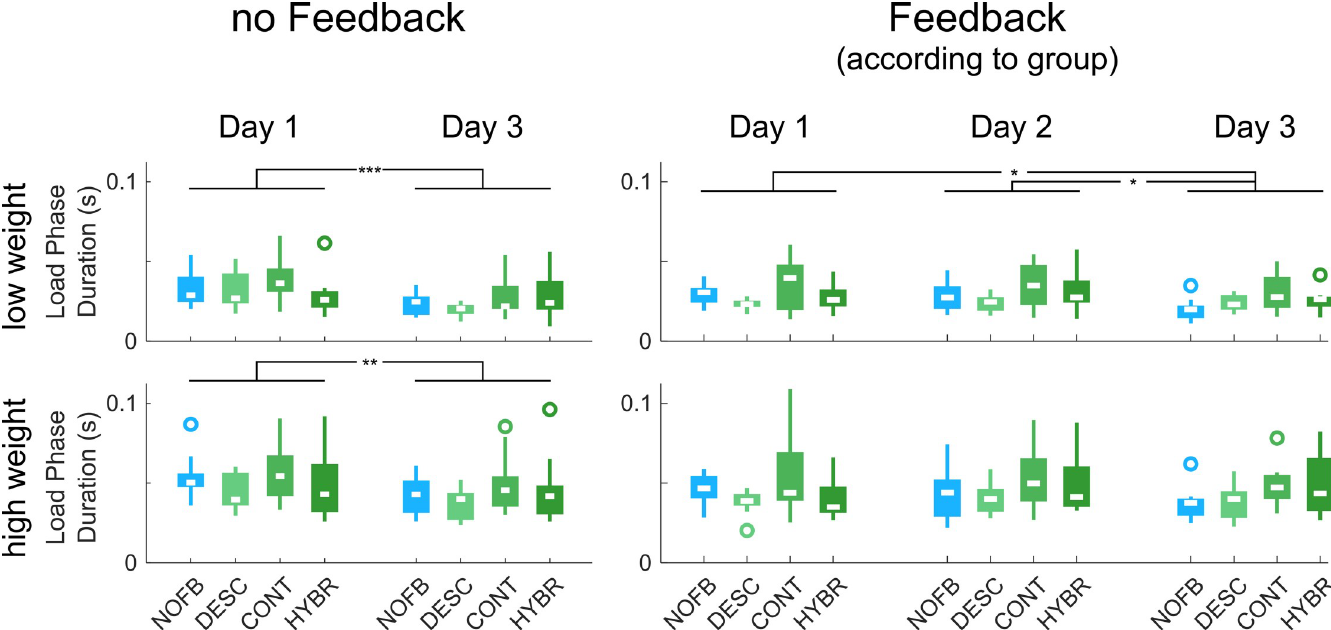
Fig 3. Duration of the load phase in Task 1 of Study 1. The graphs on the left display performance without any feedback, the graphs on the right with feedback according to group (the “NOFB” group, in blue, never received supplementary feedback). As can be seen, there are significant differences in the performance between days (irrespective of feedback group) but not between groups. Boxplots display medians, 25 th and 75 th percentiles; the whiskers denote the most extreme datapoints that are not outliers; circles denote outliers. � = p < 0.05, �� = p < 0.01, ��� = p < 0.001.